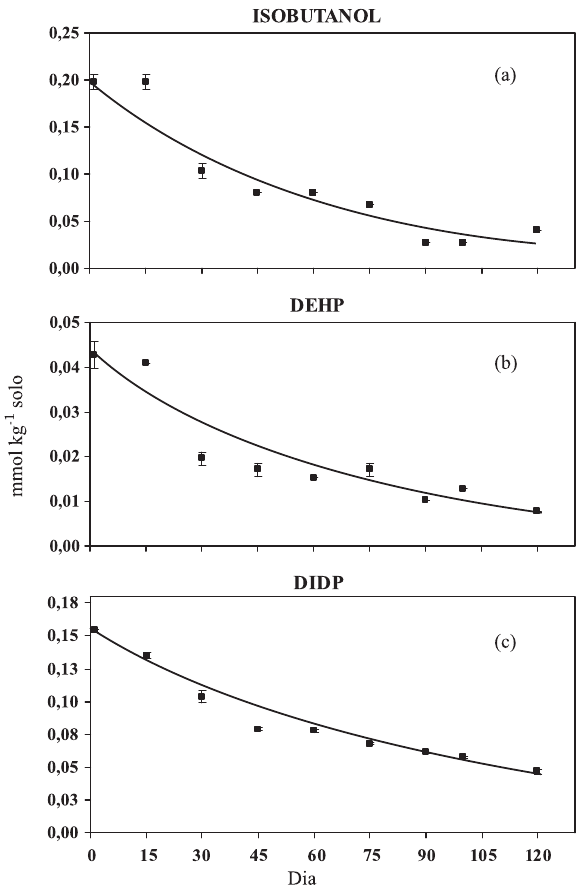
figura 4. evolução dos teores de contaminantes durante a biorremediação (a) isobutanol; (b) deHp; (c) didp. Barras representam desvio- padrão da média das